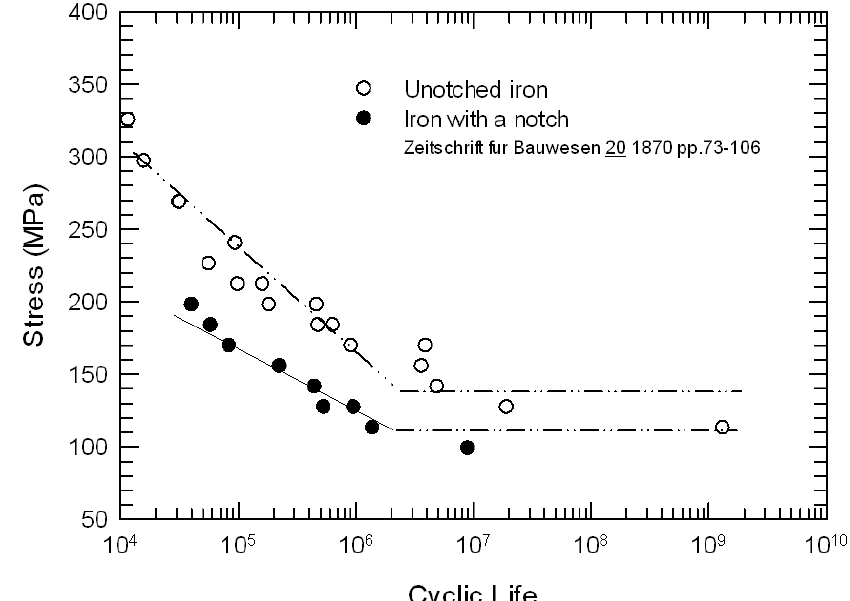
Figure 1: Fatigue data reported by Wöhler in 1870 [4] from S-N tests on notched and unnotched iron specimens. Whilst the crystallinity theory was completely discredited by 1903 (through microscopic observations of crack initiation and growth via ‘persistent’ slip band cracking made by Humphreys and Ewing [6]) the term ‘fatigue’ has remained in use to the present day to describe the process of crack initiation and/or growth under cyclic loading.